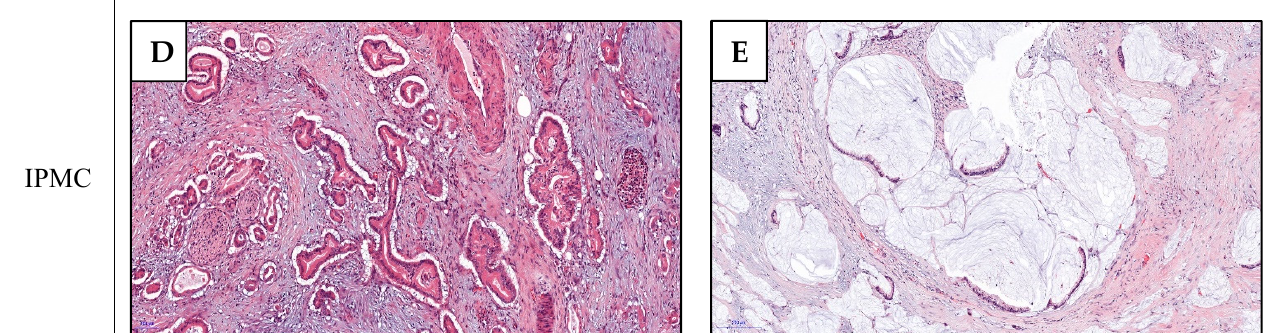
Figure 1. IPMN and IPMC subtypes. Pathological aspects of the three non-invasive IPMN subtypes: the gastric type ( A ) forms tall columnar cells with basally oriented nuclei and pale mucinous cytoplasm reminiscent of gastric foveolar epithelium; the pancreato-biliary type ( B ) has complex arborizing and interconnecting papillae composed of cuboidal cells with amphophilic cytoplasm, enlarged nuclei and prominent nucleoli; the intestinal type ( C ) forms villous papillae composed of tall columnar cells with cigar-shaped enlarged nuclei and basophilic cytoplasm with variable amount of apical mucin; IPMC are either of the tubular type ( D ) or colloid type ( E ), described above.